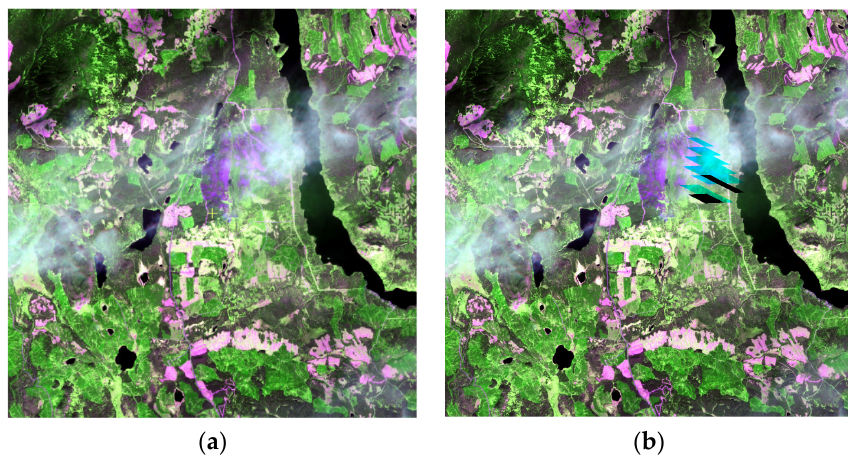
Figure 6. ( a ) The observed Sentinel-2 MSI image on the prediction date 15 August 2018 and ( b ) the same image marked with the unavailable pixel values of the MODIS image on the same day for visual comparison. The two black rectangles mean that the pixel values of MODIS BRDF adjusted image are not available for all the bands. The areas with variation of cyan color represent unavailable pixel values of the MODIS image only for the SWIR1 band.